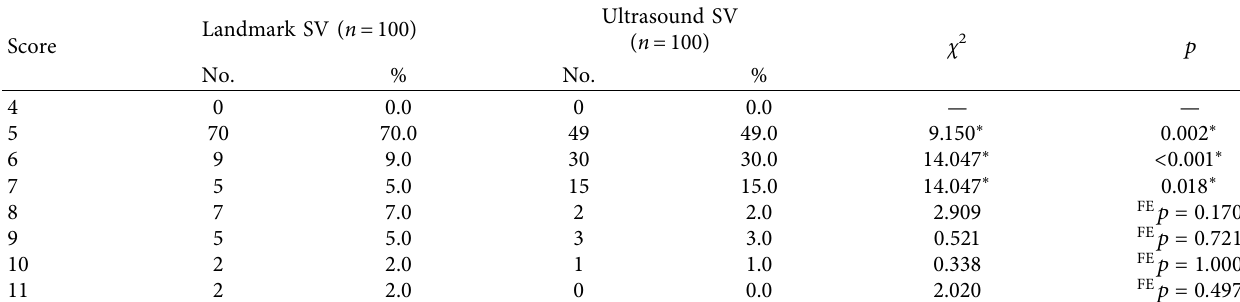
Table 5: Group B: comparison between landmark and ultrasound (SV) techniques according to our scoring system.